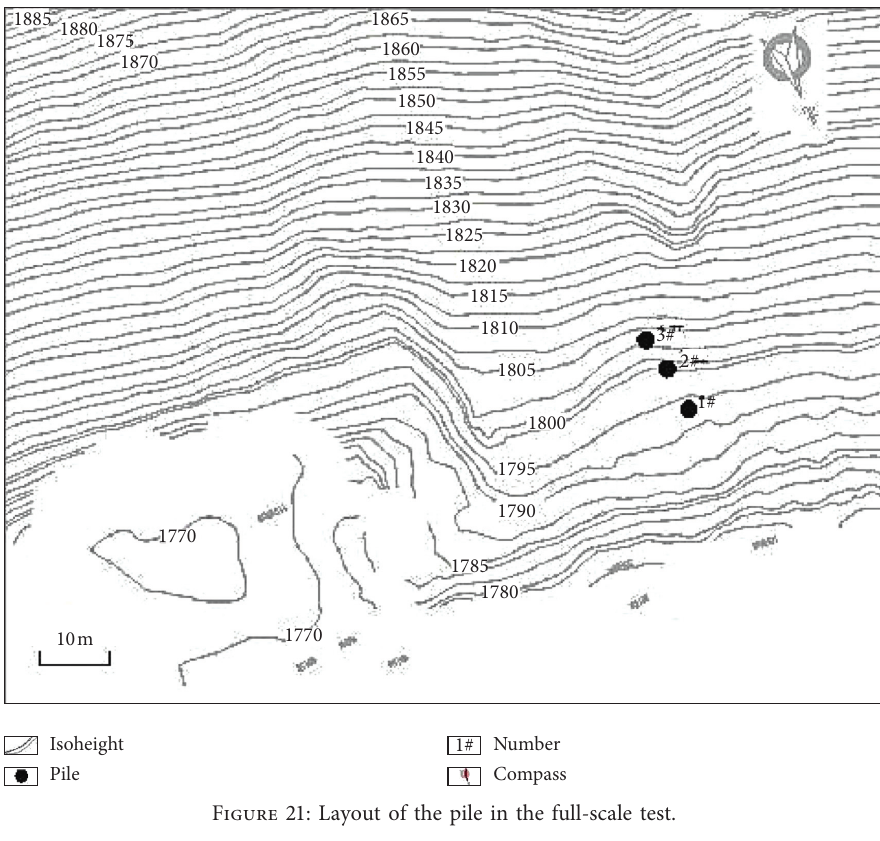
Figure 21: Layout of the pile in the full-scale test.